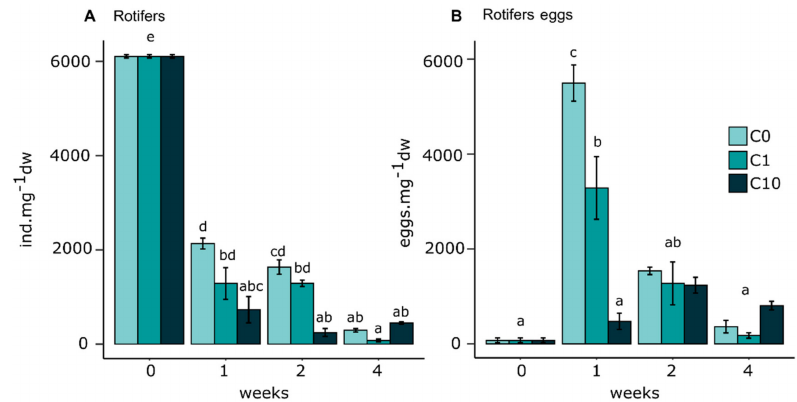
Figure 5. Number of individuals ( A ) and rotifer eggs ( B ) per mg of biofilm dry weight in control (C0 = 0.2 ± 0.1 nM) and Zr exposures (C1 = 0.5 ± 0.3 nM and C10 = 2.9 ± 0.3 nM). Values are means and standard errors. A two-way ANOVA was performed to detect significant di ff erences between treatments as indicated by letters ( p < 0.05; n = 3).